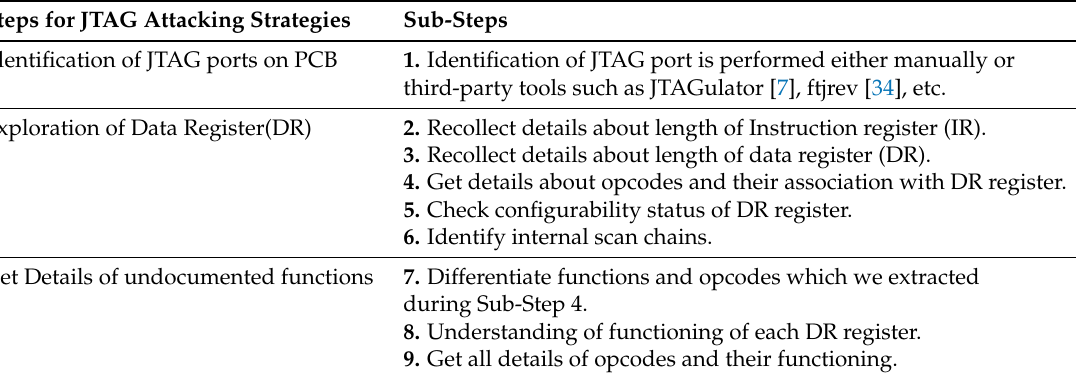
Table 1. Attacking